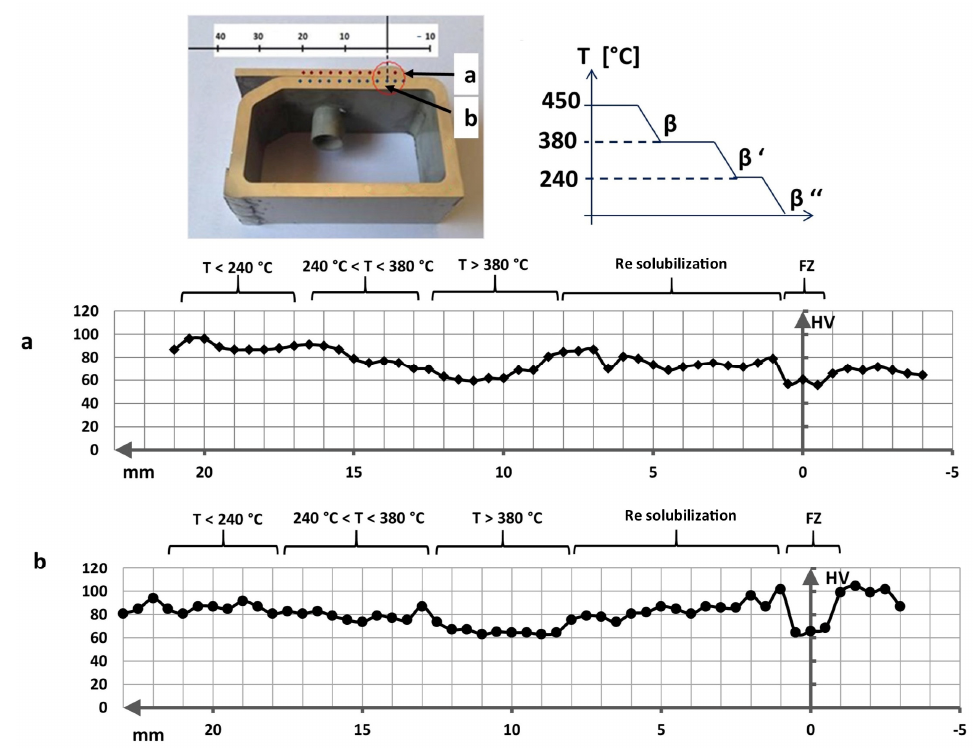
Figure 11. Evolution of the micro-hardness HV (hardness Vickers) in the E-E sub-frame combination as a function of the position along a transverse section of the weld (MIG joint).